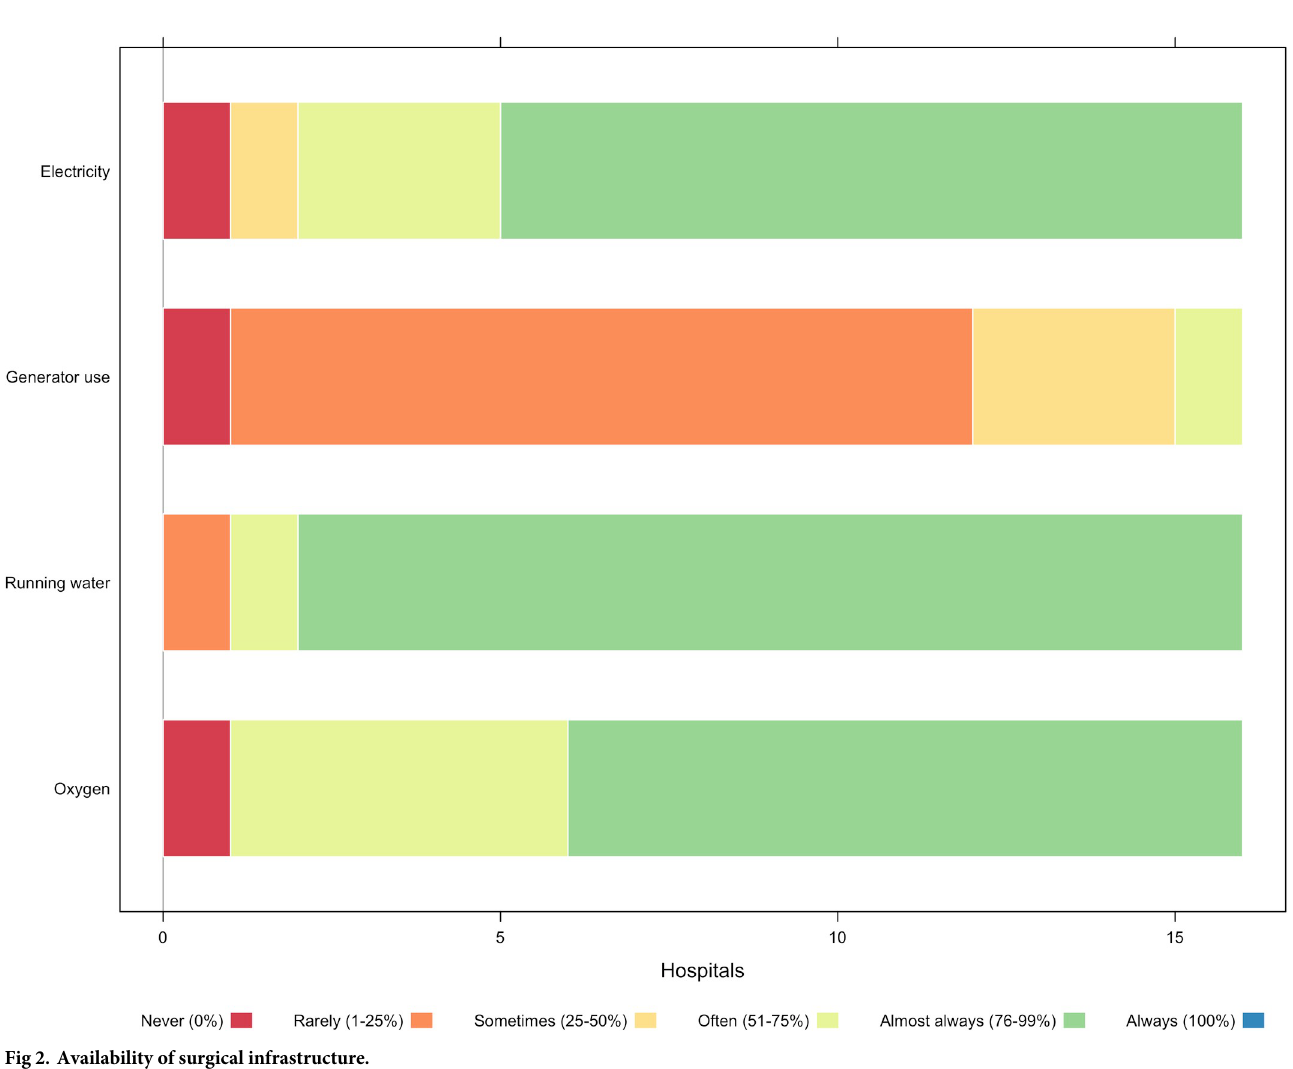
Fig 2. Availability of surgical